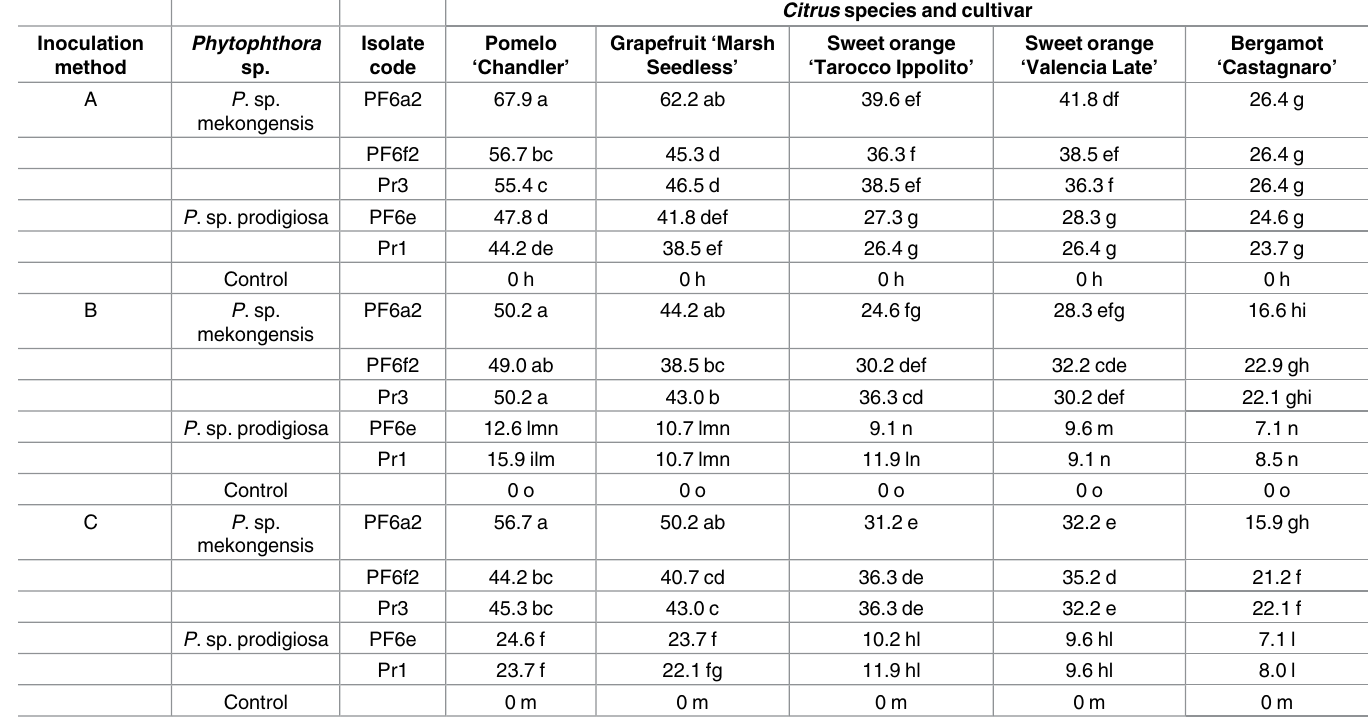
Each value represents the mean of five replicated values. In each experiment numbers followed by different letters are significantly different values of the lesions according to Tukey’s HSD test (P (cid:20)